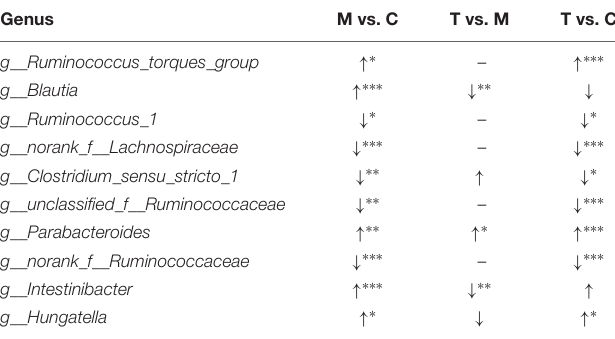
TABLE 1 | Cecum microbiota genera that showed significant changes between the control (C), antibiotic-only (M), and TACS (T) groups detected by16S rRNA gene sequencing analysis ( ∗ p < 0.05; ∗∗ p < 0.01; ∗∗∗ p < 0.001). Genus M vs. C T vs. M T vs. C